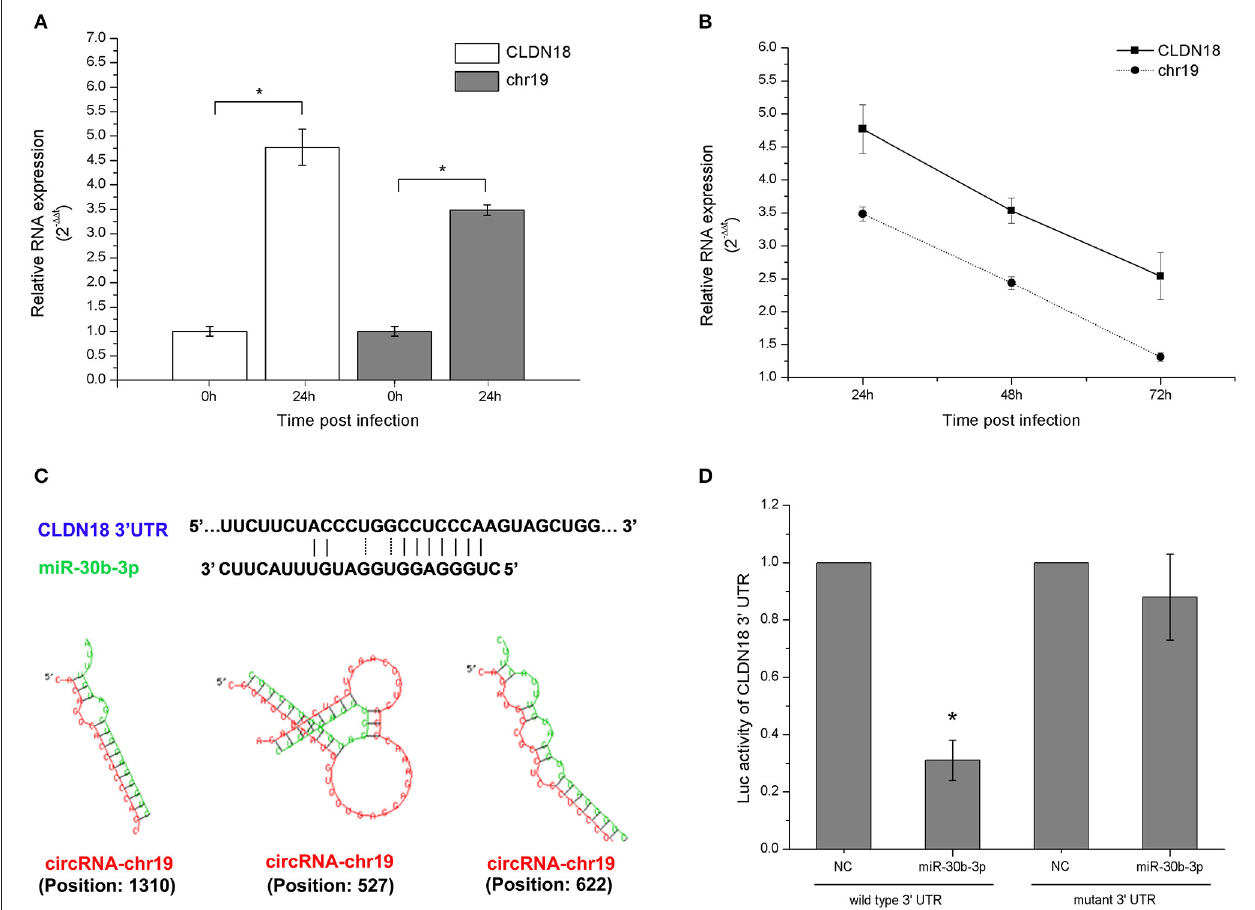
FIGURE 7 | Gene expression changes post virus infection and transfection of circRNA-chr19-targeting microRNAs. (A) CircRNA-chr19 expression in 293T cells was analyzed via qPCR at 24h and 0h post virus infection and compared. (B) The expression levels of circRNA-chr19 and CLDN18 in 293T cells infected by virus. RNA expression, which was normalized by the expression level of GAPDH, is represented by the 2 − 11 t value. (C) MiR-30b-3p matches the 3 ′ -UTRs of CLDN18 and circRNA-chr19 (indicated by solid lines). The interactions of circRNAs and mRNAs with miRNAs were predicted by miRNA target prediction software, such as TargetScan and Bielefeld Bioinformatics Service online resource. (D) Wild-type and mutant CLDN18 3 ′ -UTR activity were analyzed by luciferase reporter assays. The vector expressing miR-30b-3p was co-transfected with the vector containing the wild-type or mutant 3 ′ -UTR. The results are presented as the mean ± SD of 3 different preparations, * P <